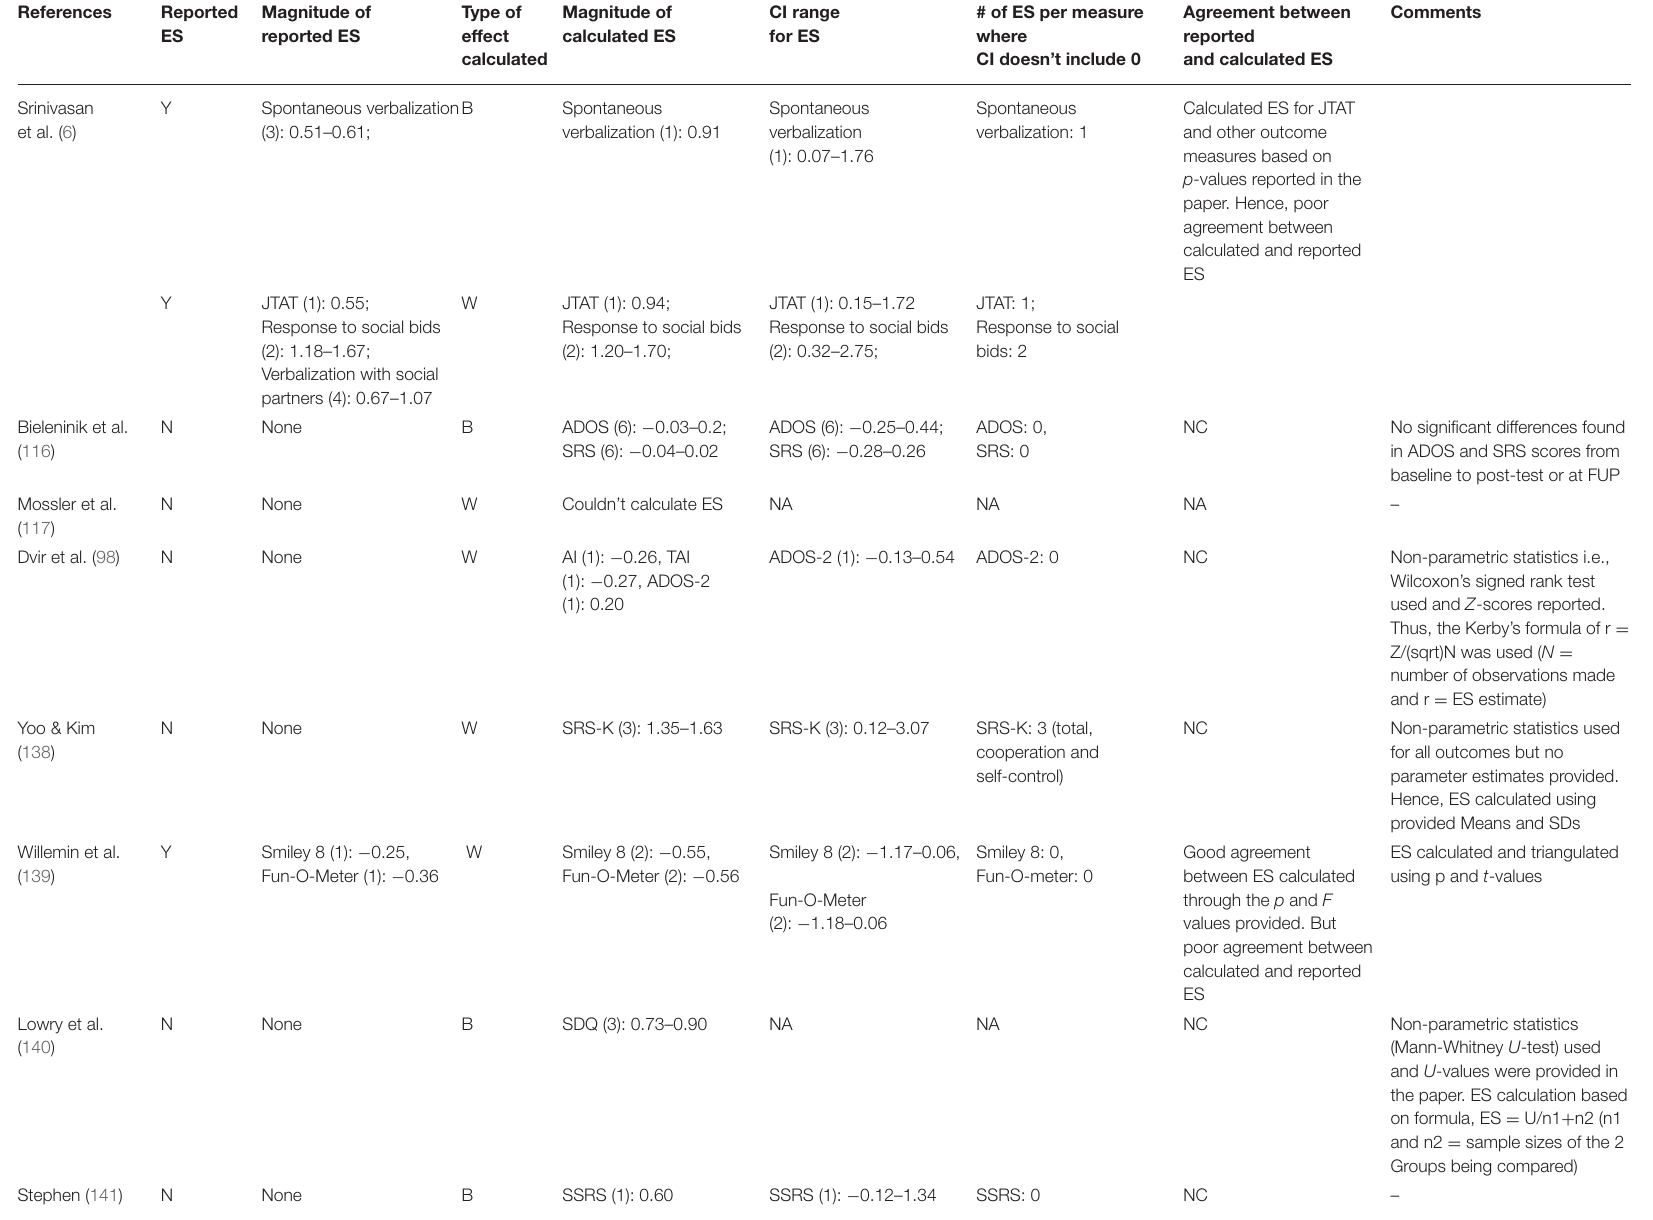
No significant differences found in ADOS and SRS scores from baseline to post-test or at FUP